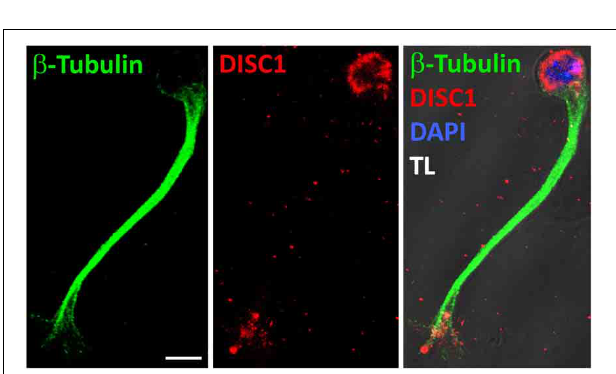
FIGURE 6 | DISC1 overlaps with microtubules in the growth cone-like structure. Fluorescent micrographs of a migrating interneuron stained with α -Tubulin as well as α -DISC1 antibodies. The leading process shaft is free of DISC1, but filled with tubulin fibers. TL, transmitted light. Scale bar: 5 μ